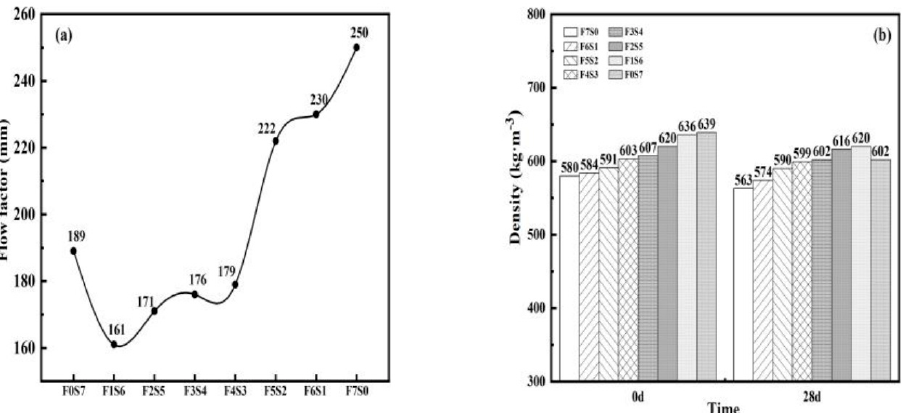
Figure 2. Working performance of the LCFLS: ( a ) flowability; ( b ) wet density and quasi-dry density.